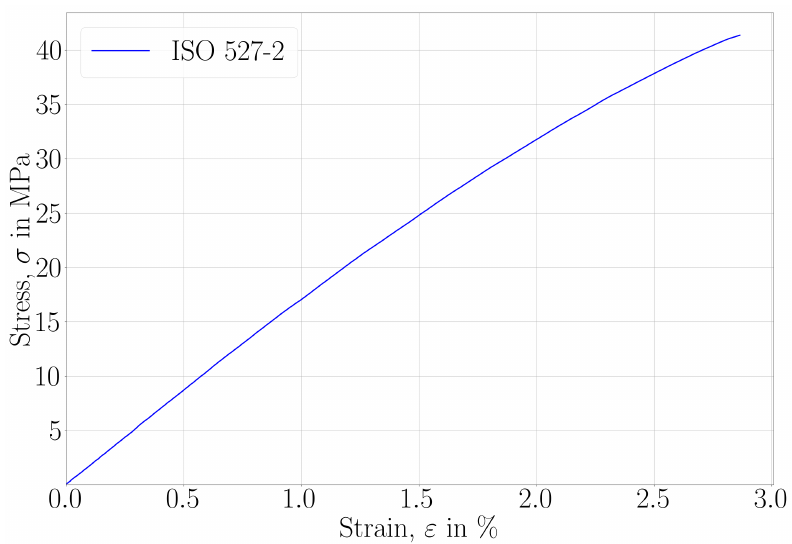
Figure 8. Stress-strain curves recorded in uniaxial tensile tests until failure with a ramp speed of